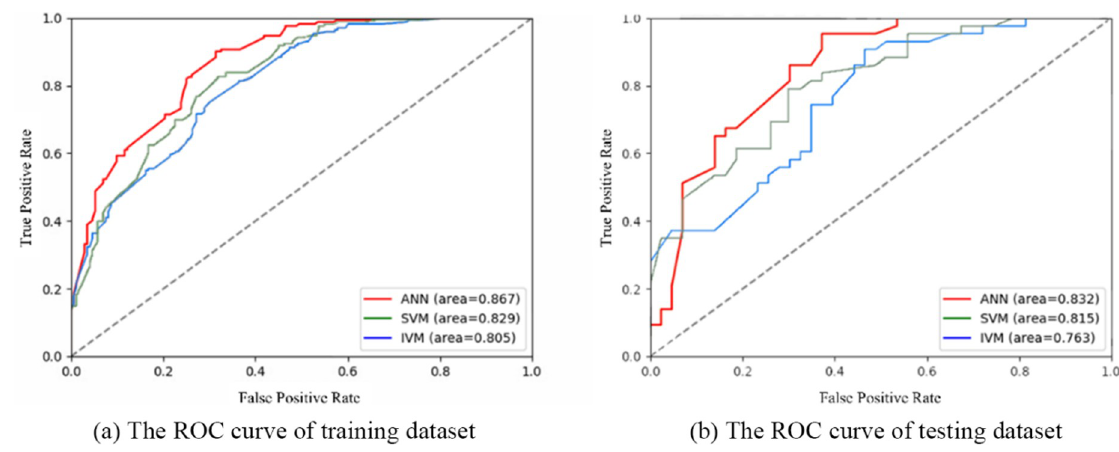
Fig 6. The ROC curves of ANN, SVM and IVM in the training and testing datasets.